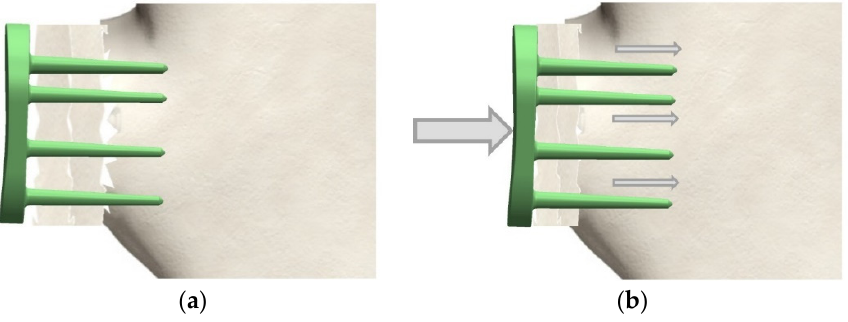
Figure 4. Dynamic fixation using angle-stable pins: ( a ) initial post-operative situation; ( b ) dynamic load results in compression and functional stimulus of the augmented